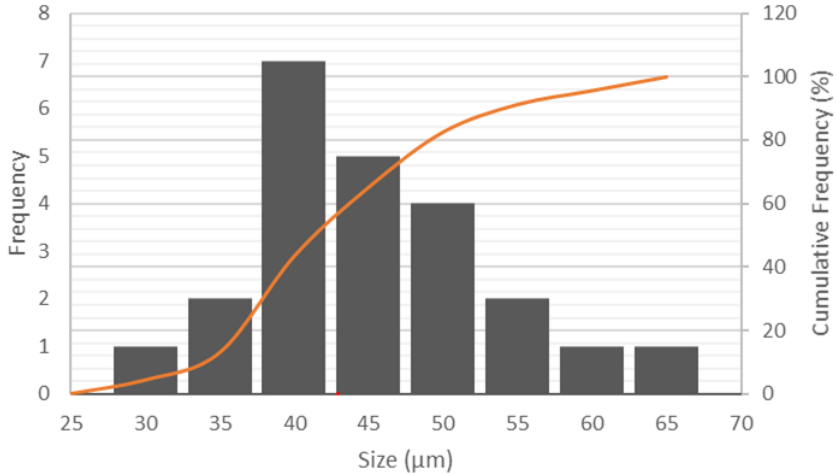
Figure 4. Particle size distribution of the 17-4 PH utilized in this research D 10 = 33 μm, D 50 = 43 μm and D 90 = 52 μm.